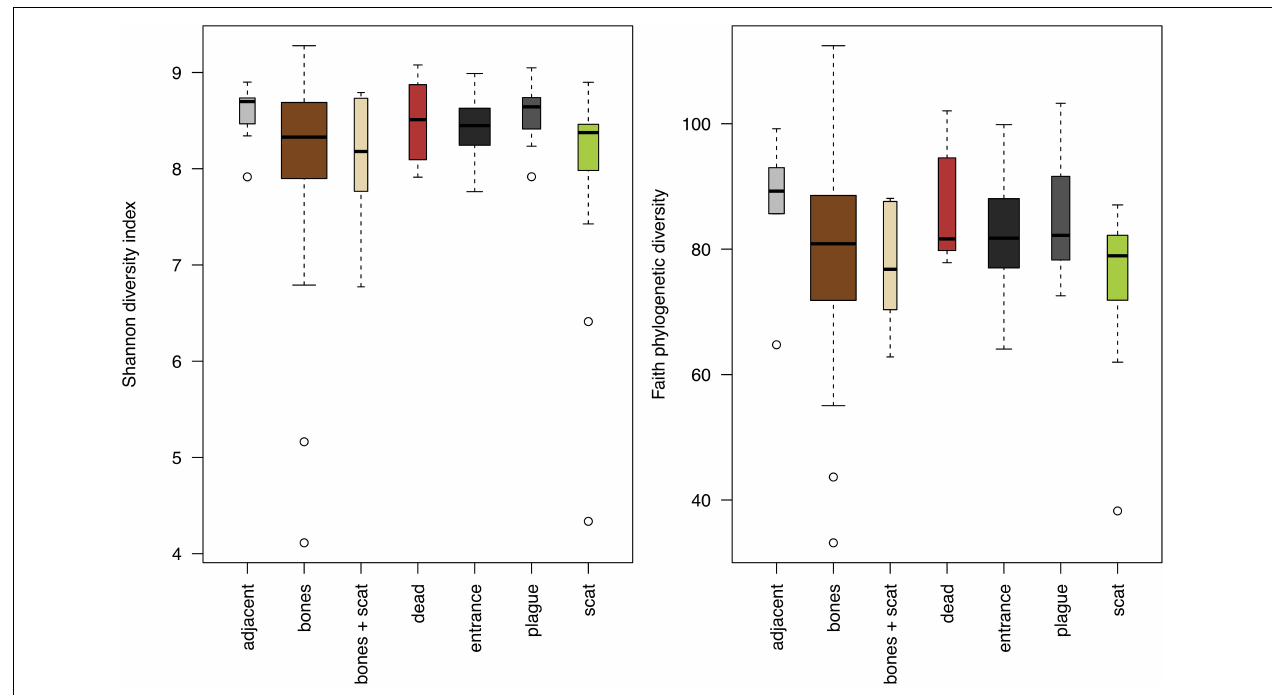
FIGURE 2 | Fine-scale variation in microbial diversity among regions of the prairie dog burrow; width of boxes represents sample size. Left: ecological diversity measured by the Shannon index. Right: phylogenetic diversity measured by the Faith phylogenetic diversity index. Width of boxes represents relative sample